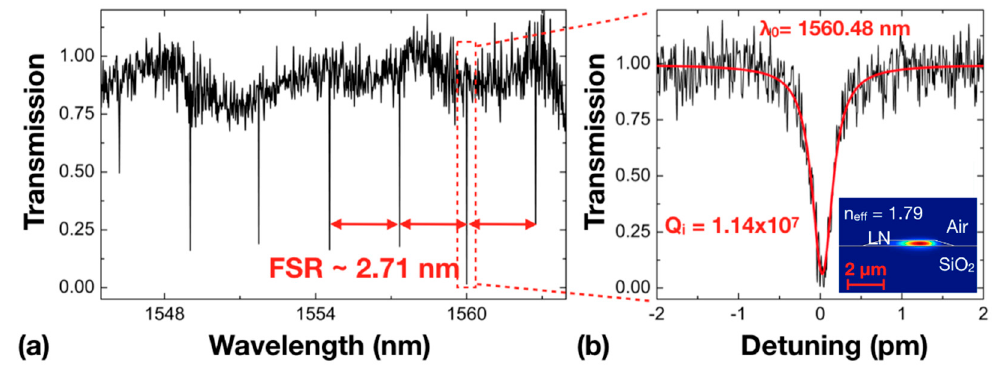
Figure 4. ( a ) Transmission spectrum of the LN microring resonator; ( b ) The Lorentz fitting (red curve) reveals a loaded Q factor of 5.70 × 10 6 , corresponding to an intrinsic Q factor of 1.14 × 10 7 . Inset: The optical mode distribution and n eff in the ring waveguide calculated using finite-difference time-domain (FDTD) simulation.